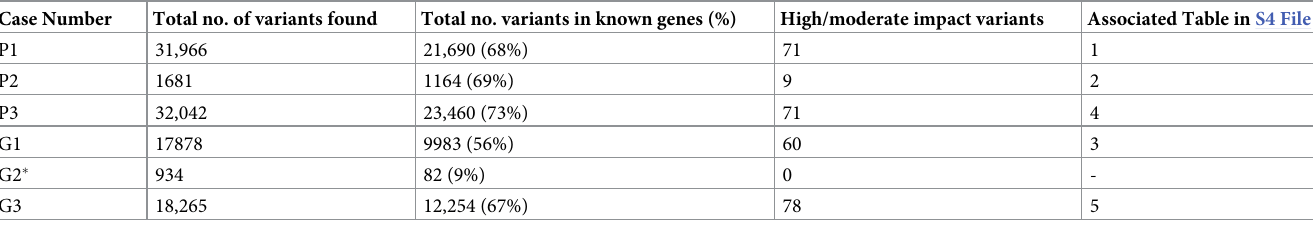
Table 1. Summary of case-specific variants.